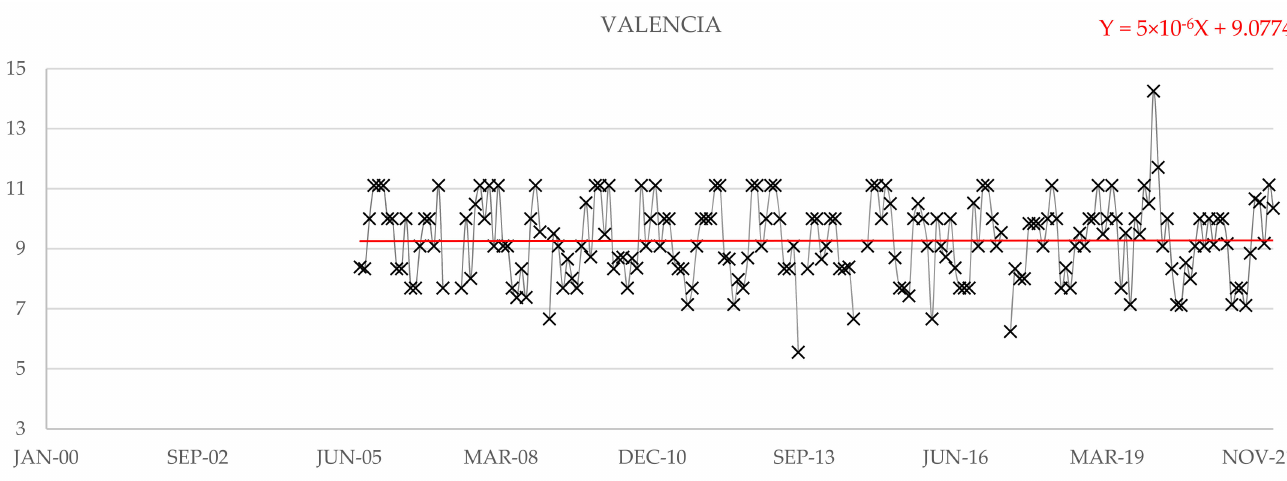
Figure 14. Evolution of Tp maxima in Cabo de Palos.